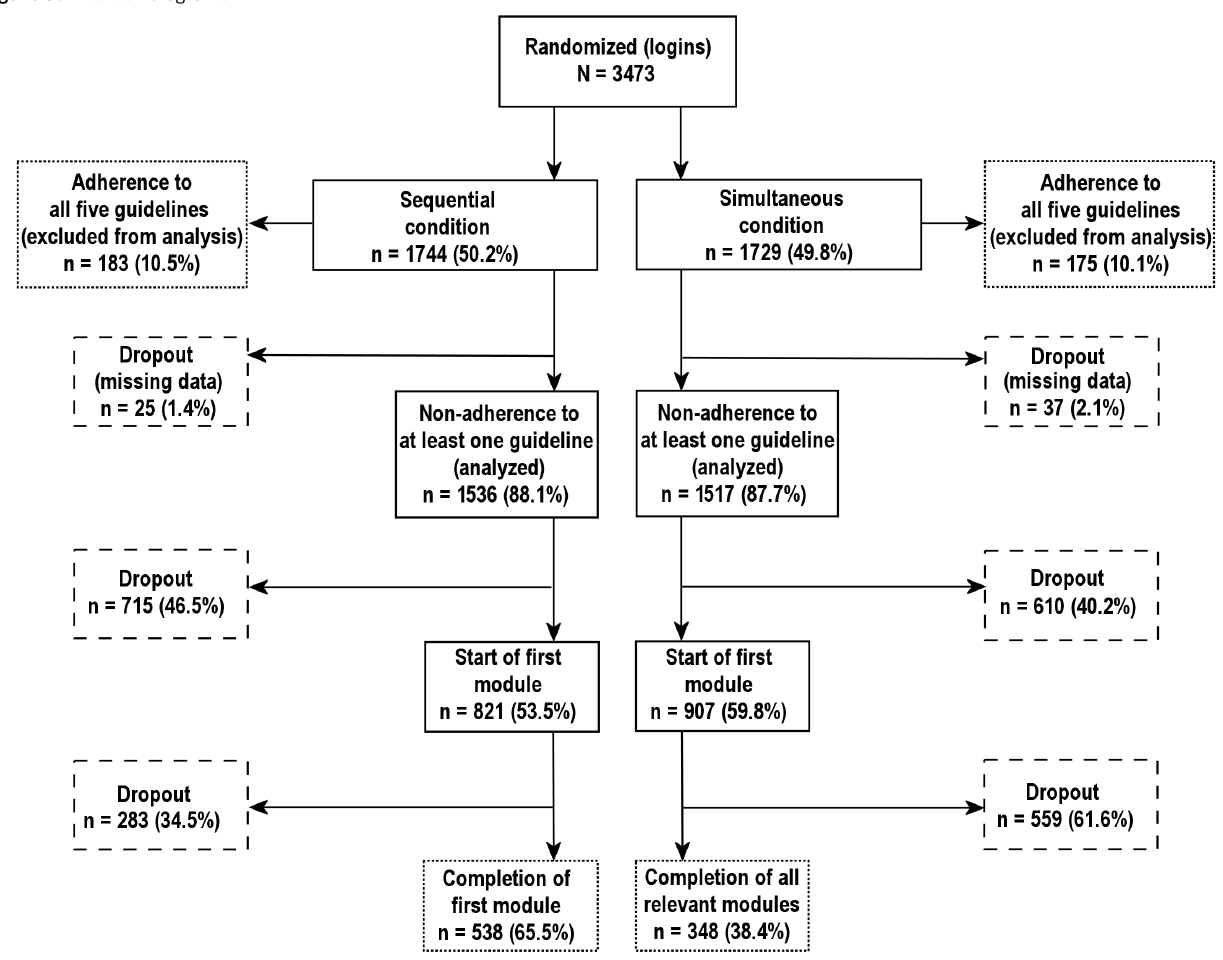
Figure 5. Attrition